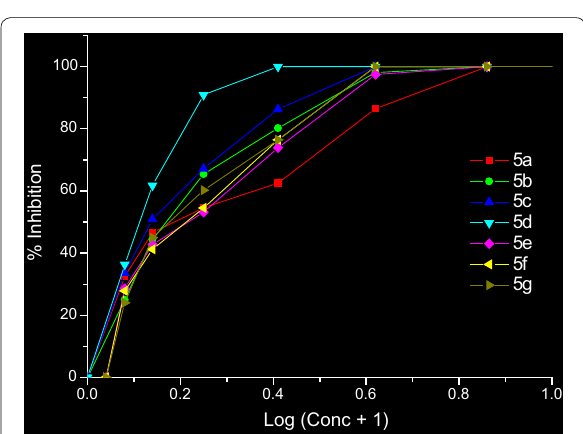
Fig. 5 Graphical representation of % inhibition of compounds 5a – 5g